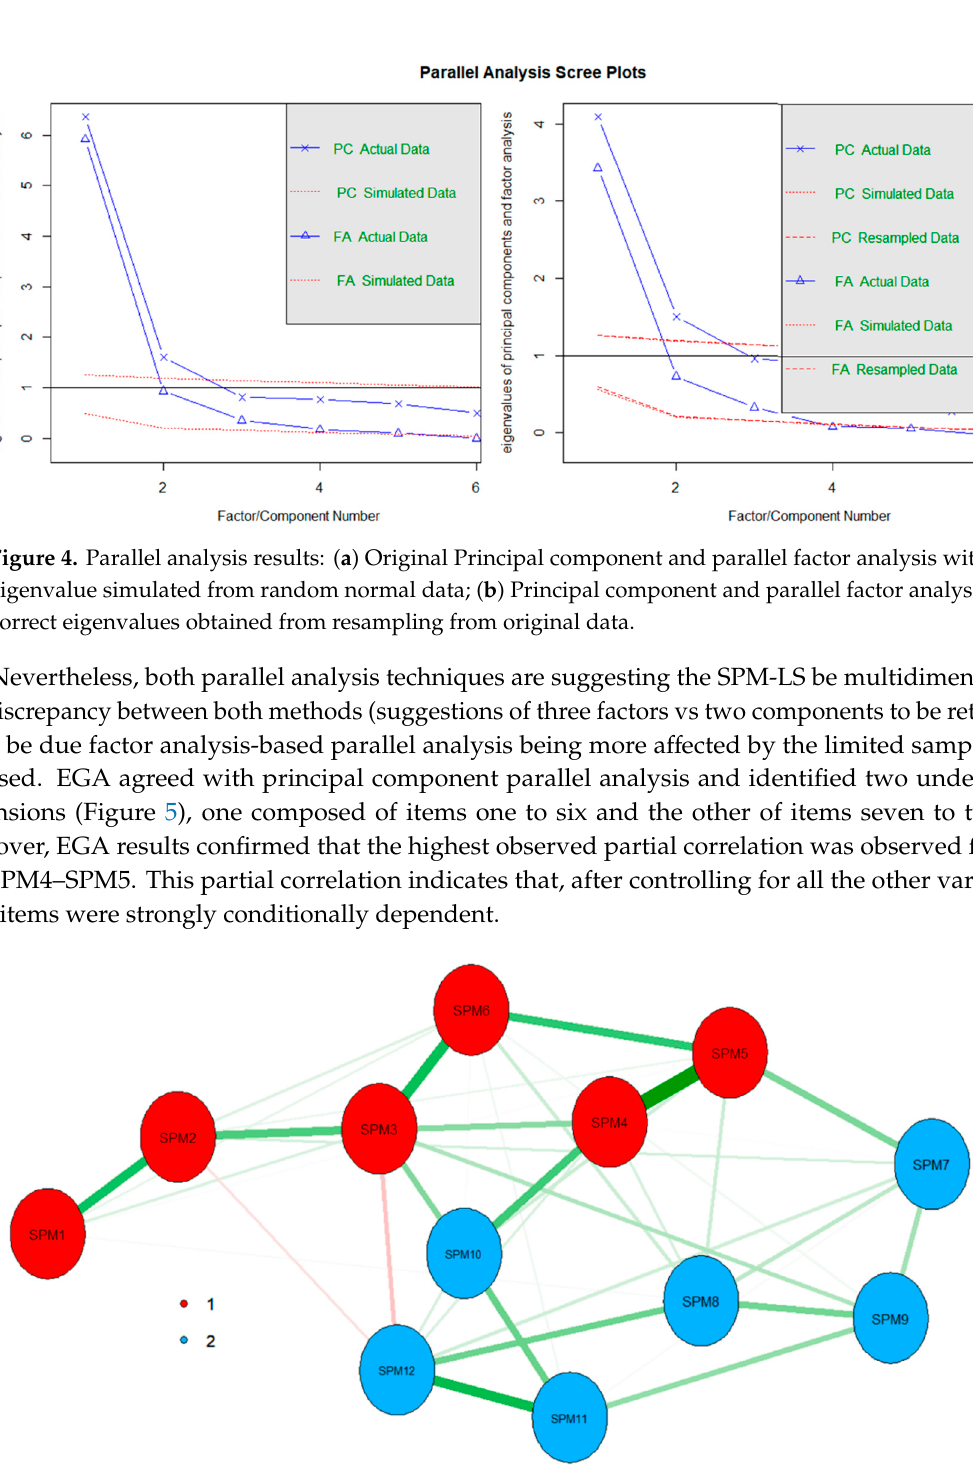
Figure 5. Exploratory Graph Analysis of SPM-LS data. Dimensions and items associated are presented in different colours. Positive partial correlations are depicted in green, with negative partial correlations presented in red. The size of the lines indicates the size of the partial correlations.